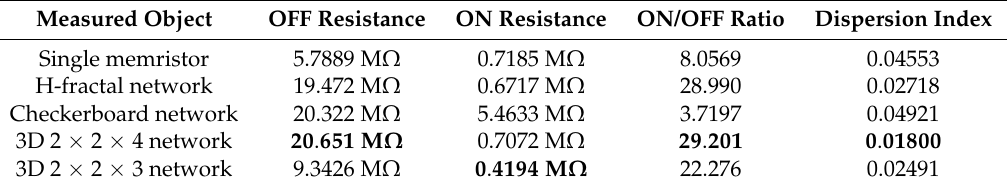
Table 1. The table shows the main properties of emulating memristor networks. Higher ON/OFF ratio is considered better and the best values are indicated accordingly, namely the highest OFF resistance, the lowest ON resistance and the highest overall ON/OFF ratio. Lower dispersion is also considered better. The lowest is